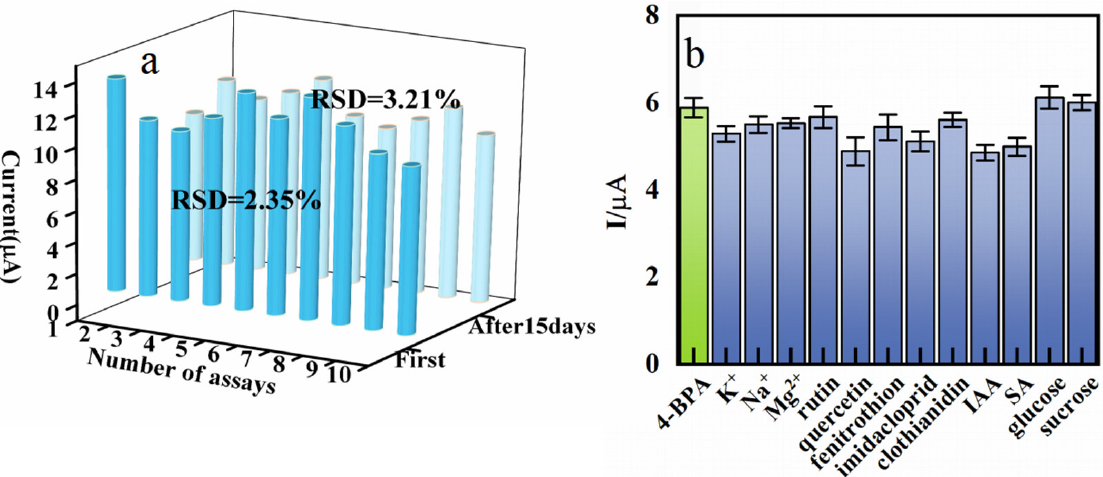
Figure 6. ( a ) The repeatability of current response for the CeO 2 /eGr/GCE in 0.1 M PBS (pH = 3) with 10 successive assays at first day and after 15 days. ( b ) The influence of other compounds on the detection of 4-BPA on CeO 2 /eGr/GCE.